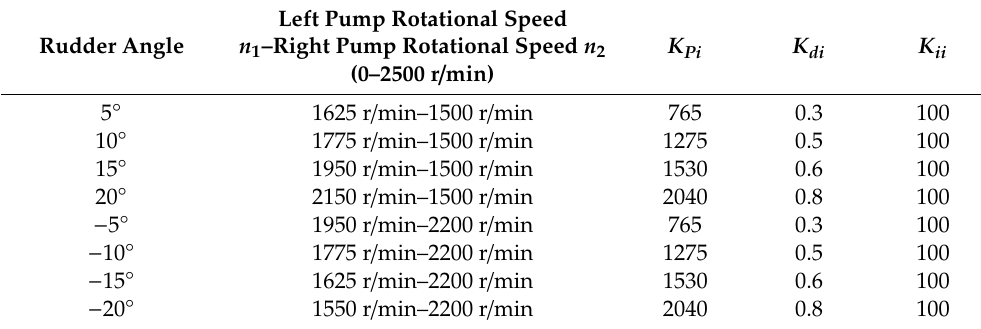
Table 4. Mapping relation of rudder angle and rotation speed n1 and n2.